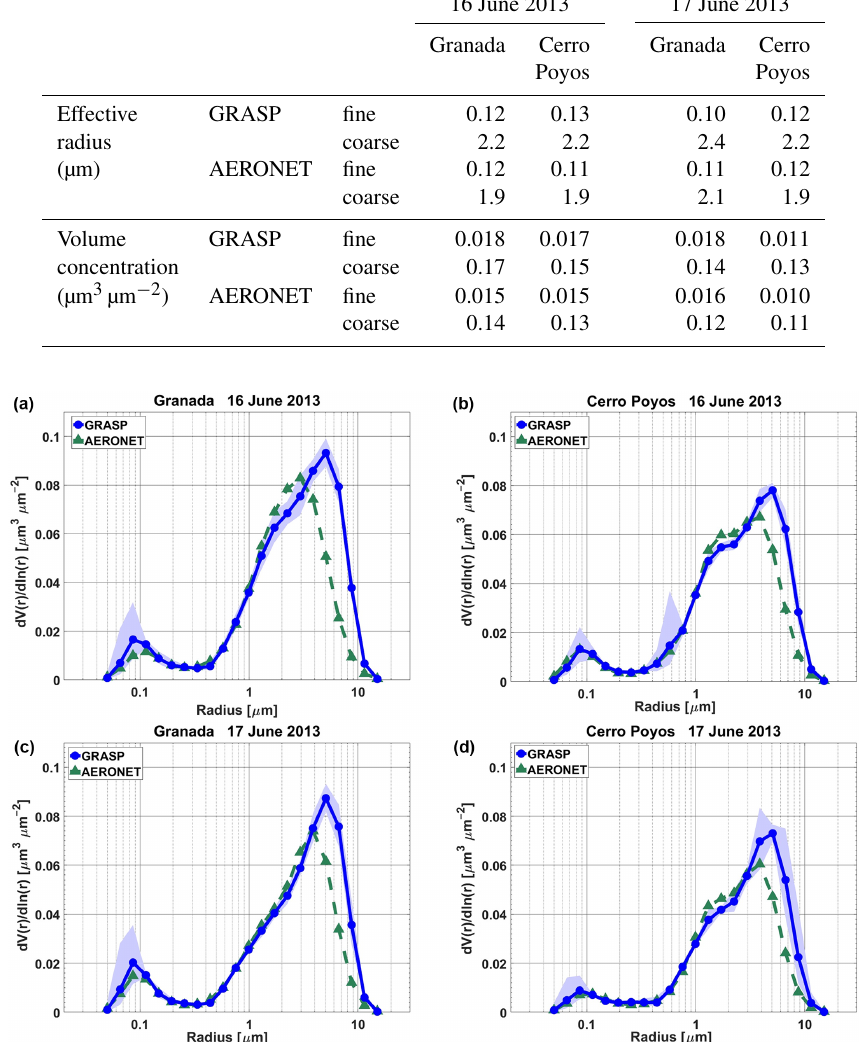
Figure 3. Size distribution retrieved by GRASP (blue) with its uncertainty (shaded area) and by AERONET (green) on 16 (a, b) and 17 (c, d) June 2013 at Granada (a, c) and Cerro Poyos (b, d)